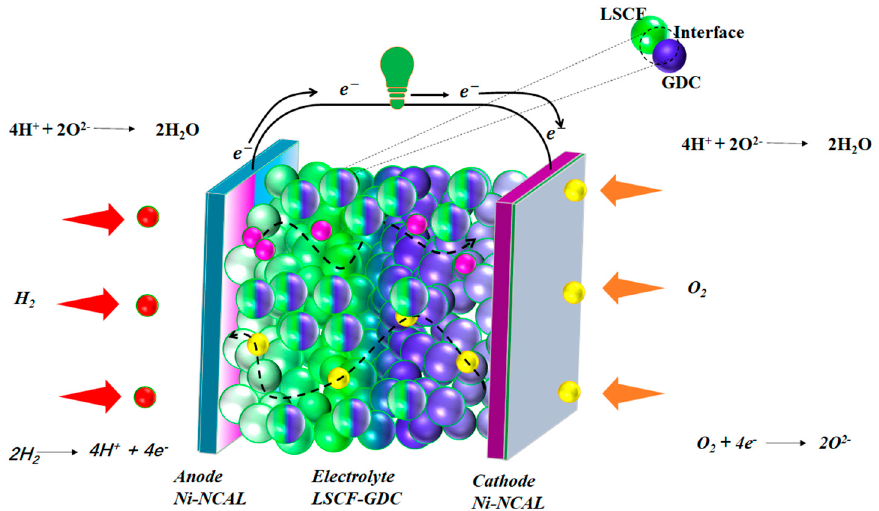
Figure 6. The different electrochemical mechanisms and processes involved in fuel cells with LSCF- GDC electrolyte-based fuel cells in producing power output based on an ionic transport membrane, Figure 6. The di ff erent electrochemical mechanisms and processes involved in fuel cells with where green ball shows the LSCF-GDC particle at anode and purple balls shows the LSCF-GDC at LSCF − GDC electrolyte − based fuel cells in producing power output based on an ionic transport cathode membrane, where green ball shows the LSCF − GDC particle at anode and purple balls shows the LSCF − GDC at cathode side.